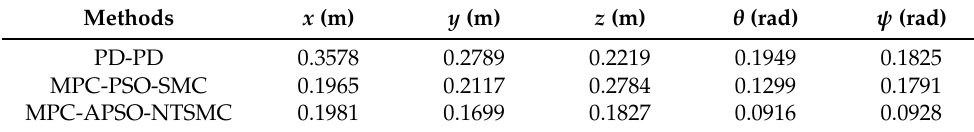
Figure 20. Velocity tracking for the AUV with wave and current disturbance for Case 1. Table 5. Position MAE with wave and current disturbance after 20s for Case